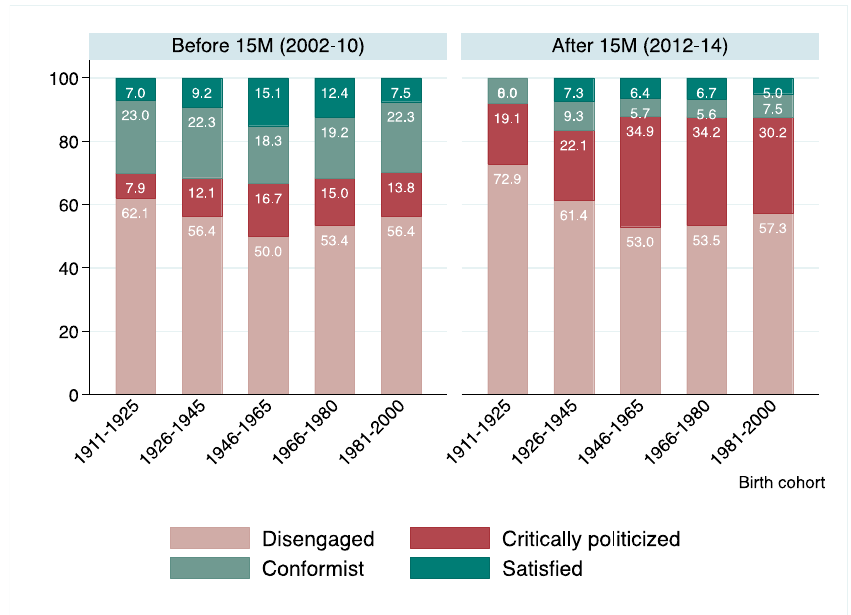
Figure 7. Typology of attitudes towards politics before and after 15-M, by birth cohorts. Birth cohorts: 1911–1925 (greatest generation), 1926–1945 (silent generation), 1946–1965 (baby boomers), 1966–1980 (generation X), and 1981–2000 (millennials). See Note 5. Source: European Social Survey in Spain, rounds 1–7.